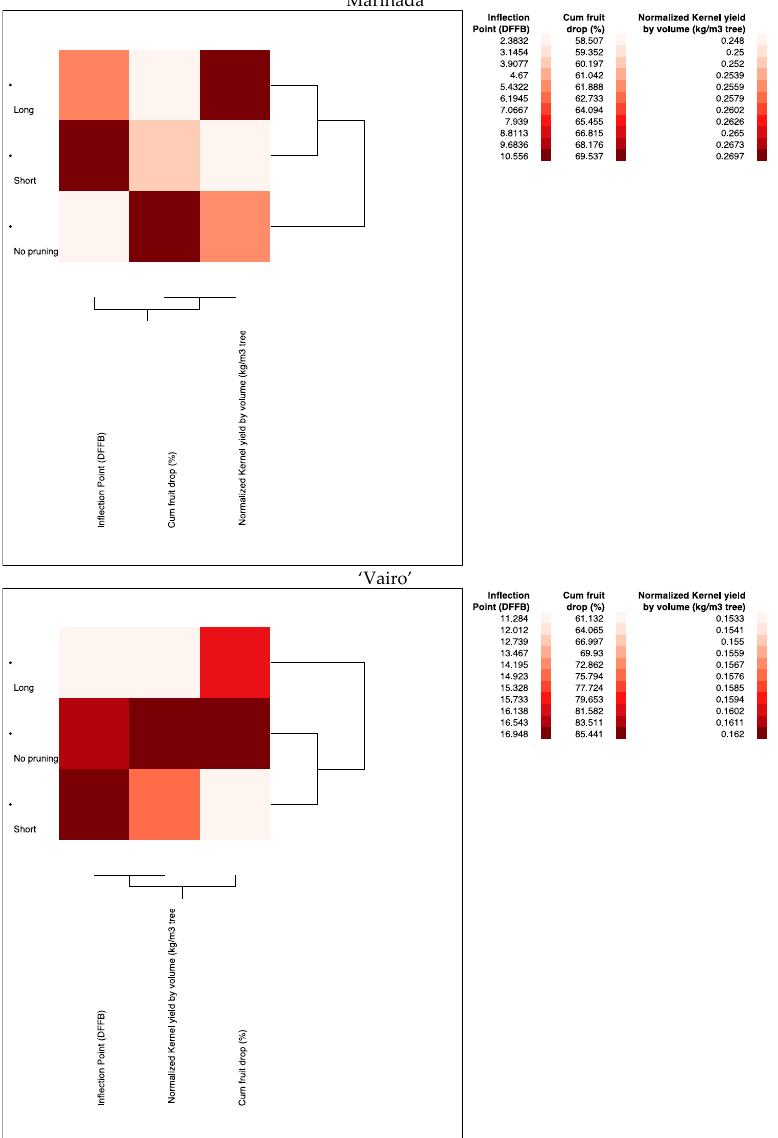
Figure 8. Clustering of ‘Marinada’ and ‘Vairo’ according to their pruning type (no pruning, long pruning, and short pruning) based on percentage fruit drop (%), inflection point (days from full bloom that fruit drop began to deaccelerate), and kernel yield (kg/tree) normalized by tree volume (m 3 ) at Les Borges Blanques, Spain (P3). Data were recorded during 2017–2018.